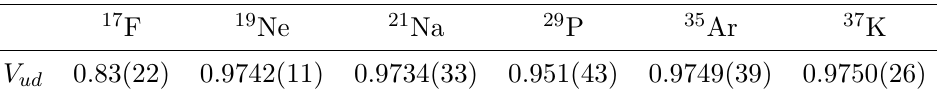
Table 4 . Values of V ud obtained from each individual mirror